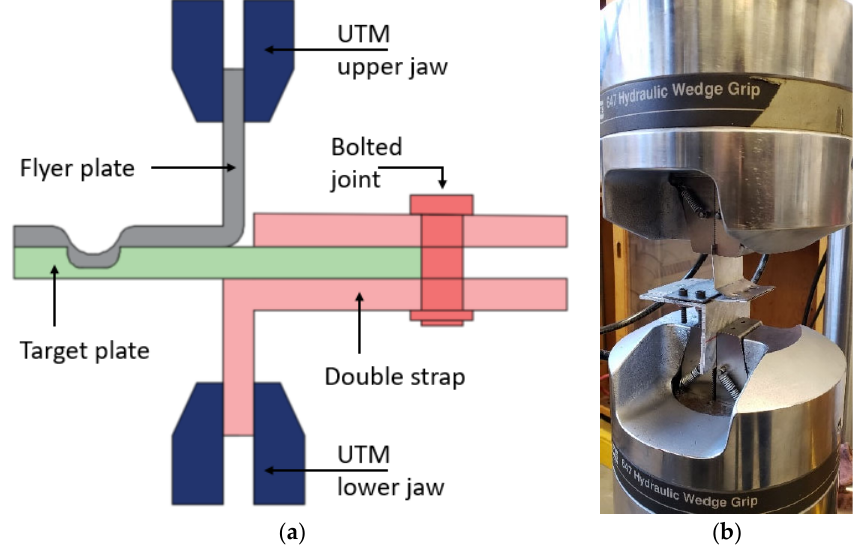
Figure 11. ( a ) A line drawing of the peel test and ( b ) experimental set ‐ up on UTM.